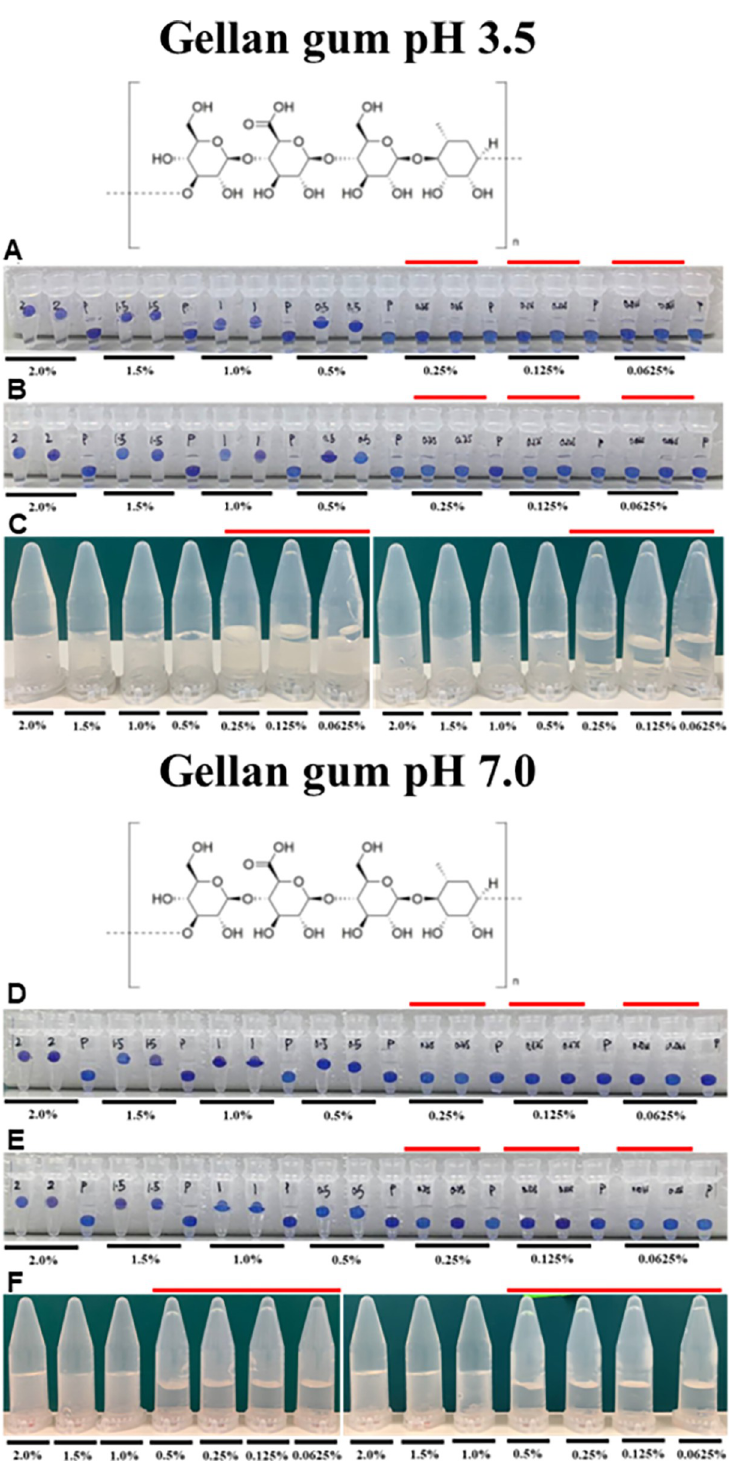
Fig 5. Low acyl gellan gum gels form stronger gels at pH 3.5 compared to pH 7.0. Representation of gelation results of pH 3.5 and pH 7.0 non-supplemented low acyl gellan gum are represented in panels (A)-(C) and (D)-(F respectively. Panels (A) and (D) Thermocycler–Floating Sphere Assay; Panels (B) and (E) Water bath–Floating Sphere Assay; Panels (C) and (F) Water bath–Inversion Assay. Red line indicates the concentrations below the critical gelling concentration. A minimum of 3 biological replicates was performed. Results from two additional replicates are presented in S5 and S6 Figs.